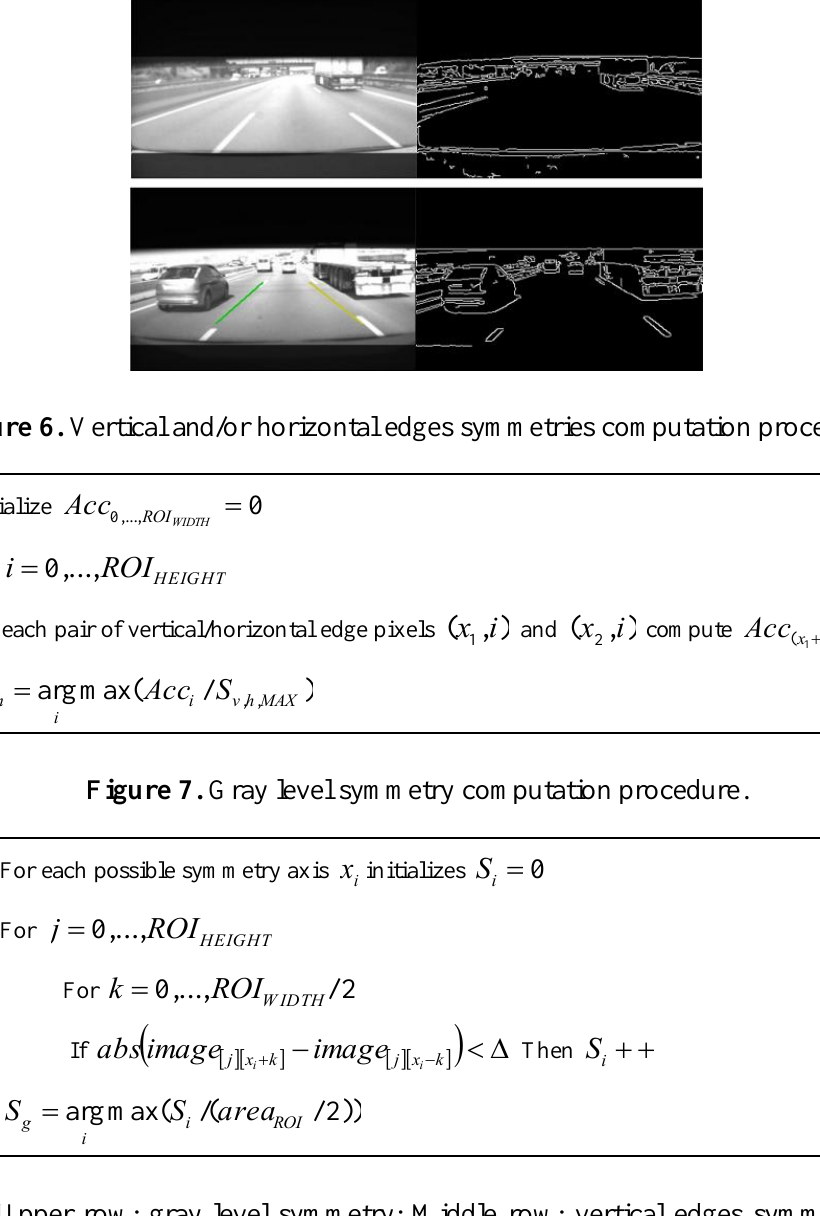
Figure 8. Upper row: gray level symmetry; Middle row: vertical edges symmetry; Lower row: horizontal edges